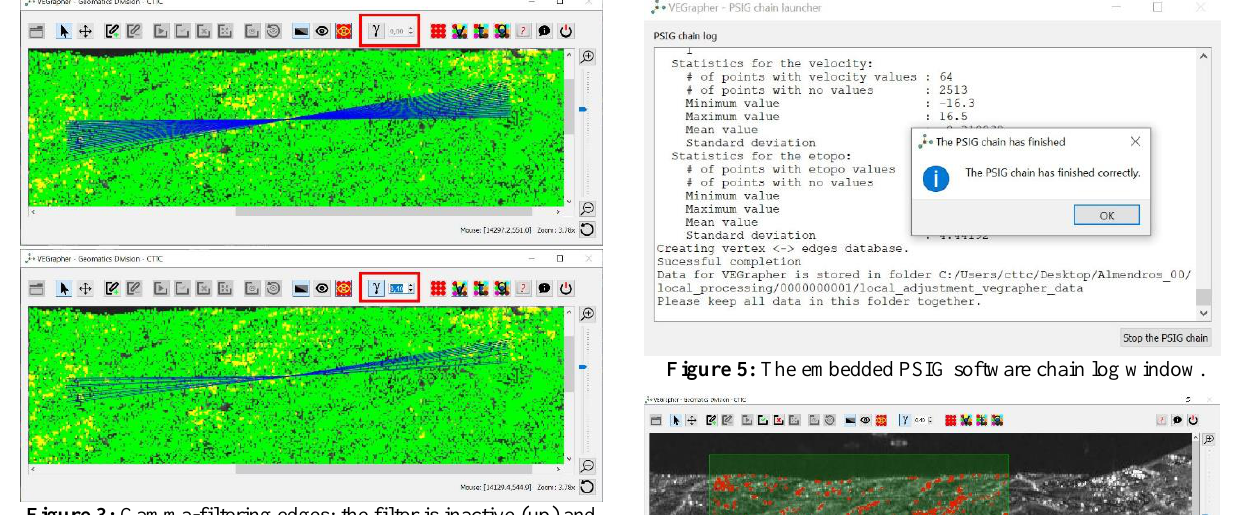
Figure 3: Gamma-filtering edges: the filter is inactive (up) and active (down) with a gamma value 0.4.